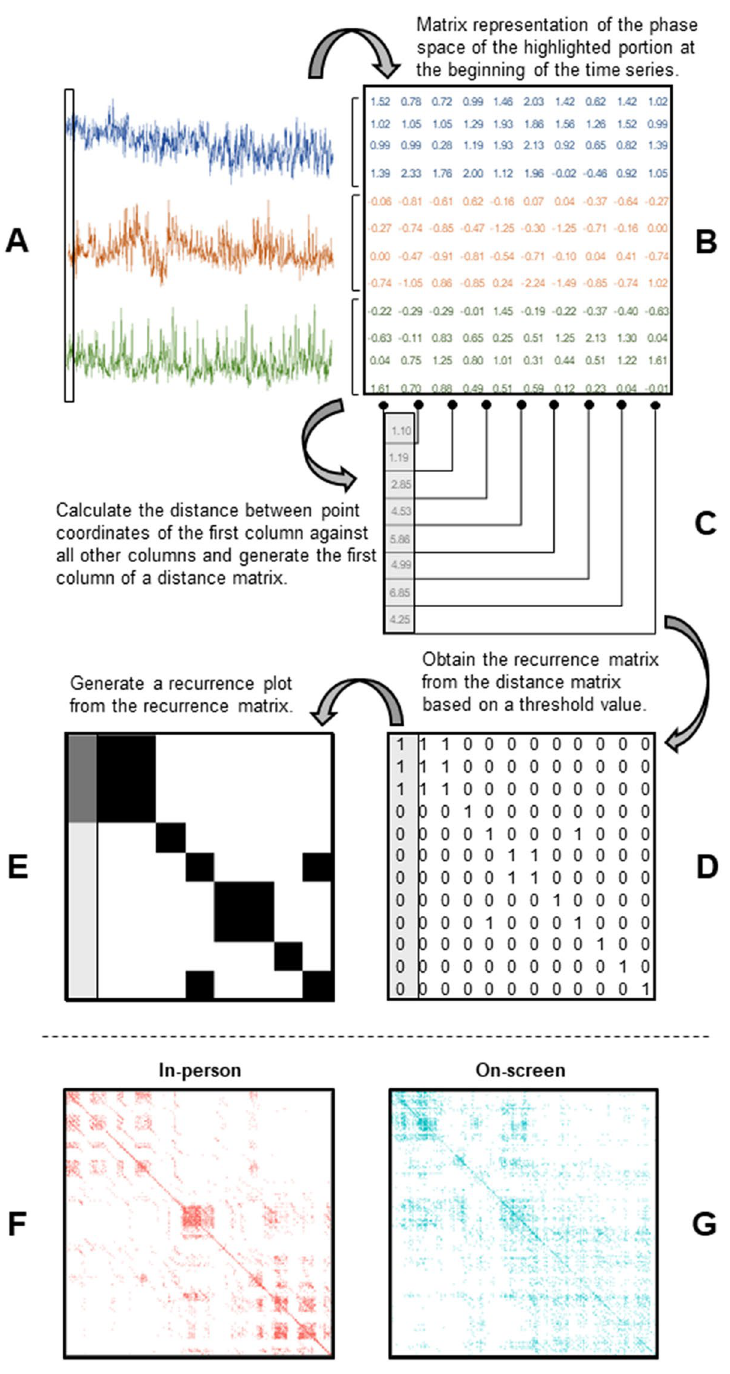
Figure 2. MdRQA procedures and outcomes. ( A ) Representative segments of three normalized heart rate time series. ( B ) State space matrix built from the combination of heart rate time series after the average delay and the average embedded dimension were obtained. Only the highlighted portion of the time series is shown in the phase space matrix. ( C ) Distances between the point expressed in the coordinates of the first column and the points with coordinates defined in the other columns of the phase state matrix. ( D ) Recurrence matrix obtained after applying a distance criterion to the distance matrix. When a cell in the distance matrix contains a value within this criterion, a “1” is assigned to its correspondent position in the recurrence matrix; otherwise, a “0” is assigned. ( E ) Recurrence plot obtained from the recurrence matrix. Where the recurrence matrix contains a 1, a black square is drawn. In turn, white squares are drawn for 0 s. The first column is highlighted to show its correspondence with the first columns of the recurrence and the distance matrices. ( F, G ) Representative recurrence plots for each